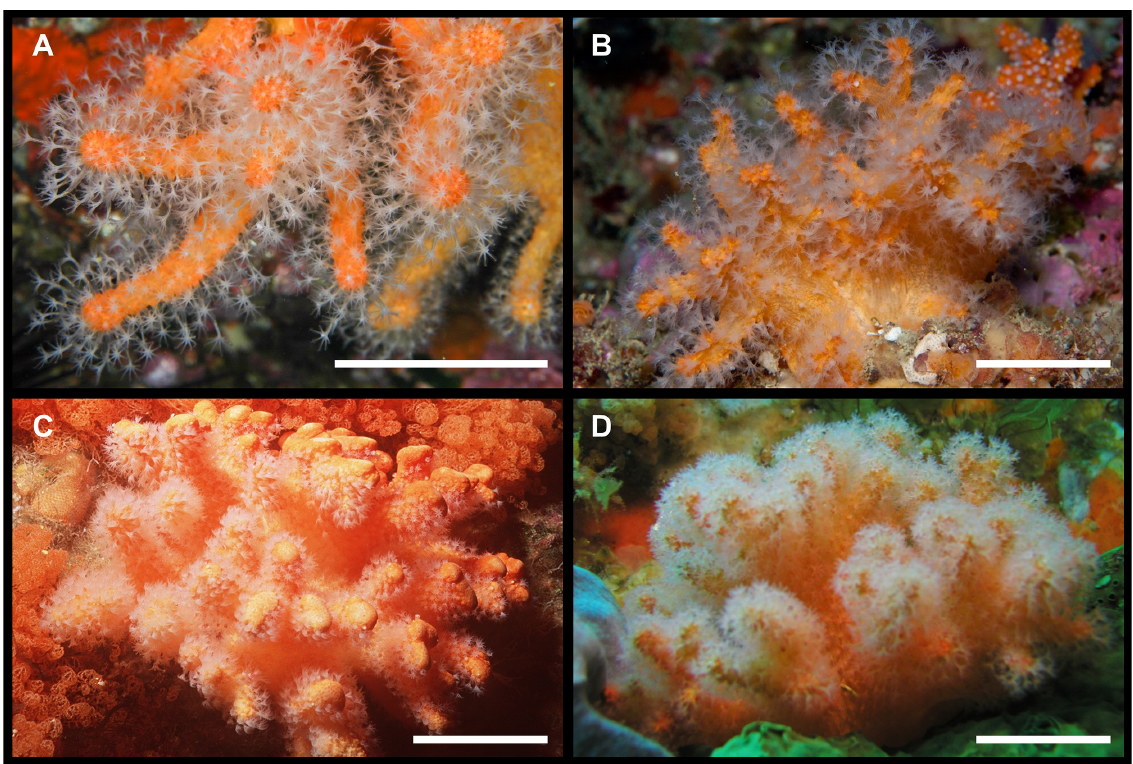
Fig. 3. In situ photographs of species of Kotatea gen. nov. usually possessing finger-like lobes. A–B . K. aurantiaca gen. et comb. nov. (uncollected specimens), expanded colonies with a contracted colony in upper right background of B, Poor Knights Islands, photos by Ian Skipworth (ianskipworth.com). C . K. aurantiaca gen. et comb. nov. (MAGNT C013957/NIWA 101181), large colony, Bay of Plenty, photo by Coral Reef Research Foundation. D . K. raekura gen. et sp. nov., holotype (NIWA 101537), Manawatāwhi/Three Kings Islands, photo by NIWA. Scale bars = ~3